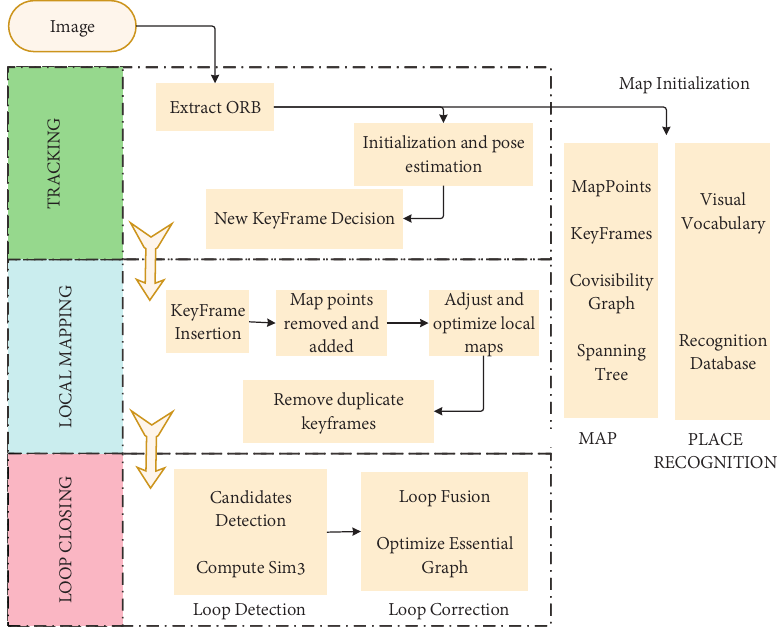
Figure 10. Flow chart of ORB-SLAM.